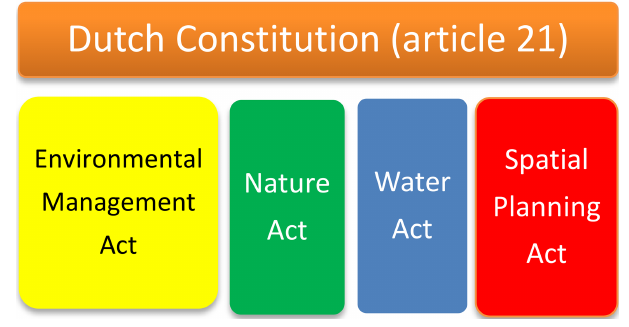
Figure 3. Sectoral environmental protection